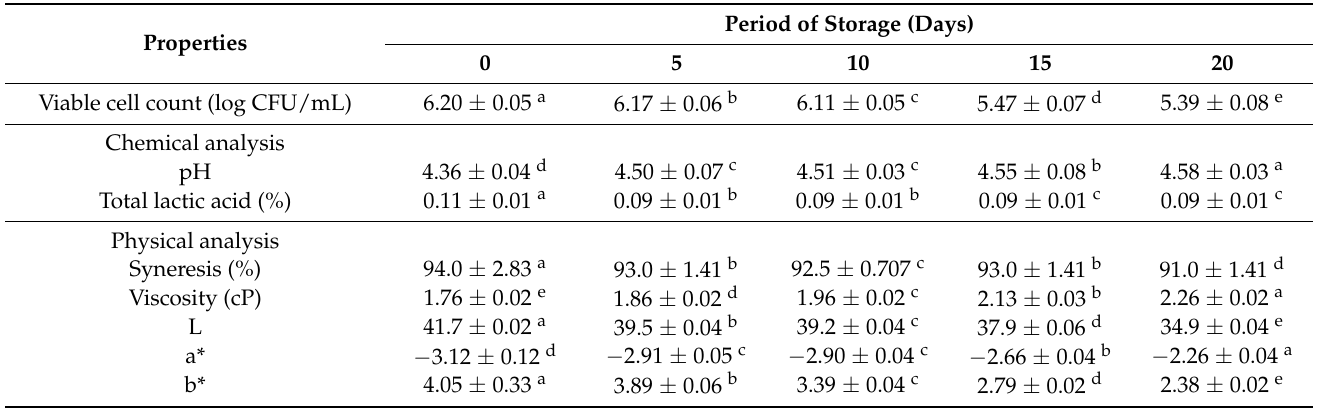
Table 2. Effects of storage time on quality changes in green soybean yogurt